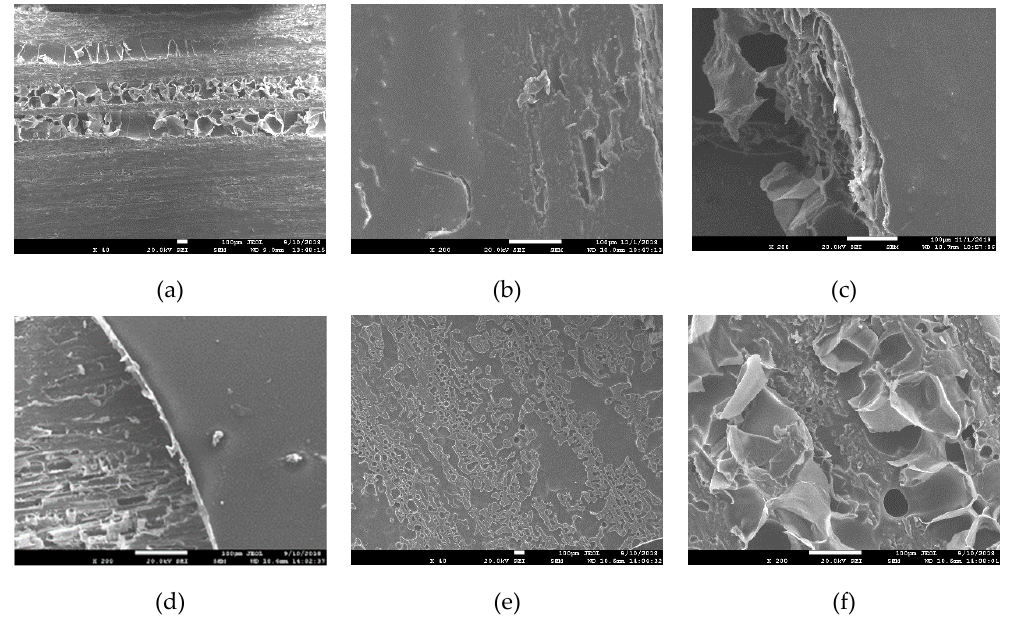
Figure 4. SEM images of oak before and after coating at different coating amount. ( a ) pure oak; ( b ) 12 g / m 2 PUA coated oak; ( c ) 60 g / m 2 PUA coated oak; ( d ) 120 g / m 2 PUA coated oak; ( e , f ) the back surface of coating peeling from the oak; ( a , e ) the magnification was × 40; ( b – d , f ) the magnification was × 200.